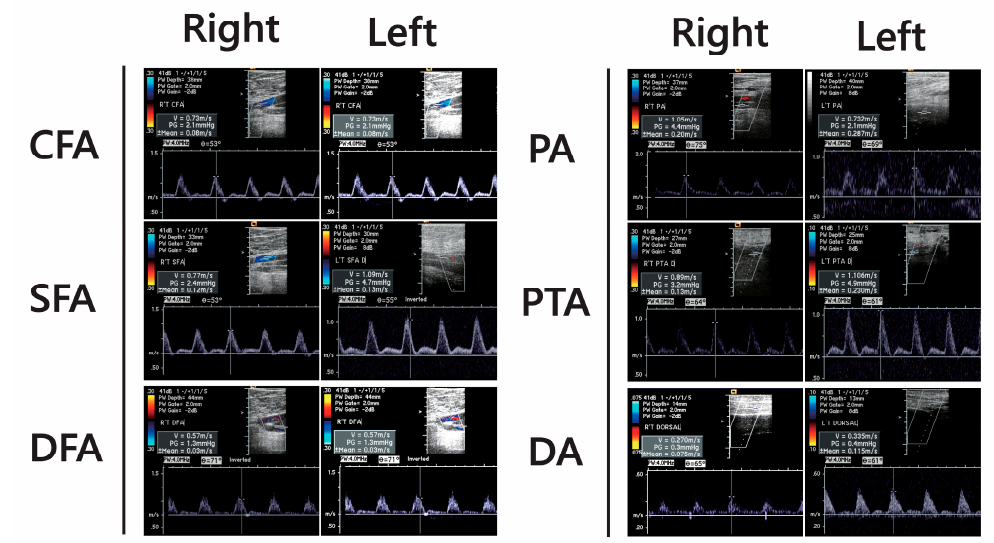
Figure 2. The doppler ultrasound of extremities revealed no significant decrease of blood flow or abdominal atherosclerosis in vessels. Right: right leg; Left: left leg; CFA: common femoral artery; SFA: superficial femoral artery; DFA: deep femoral artery; PA: popliteal artery; PTA: posterior tibial artery; DA: dorsalis pedis artery.